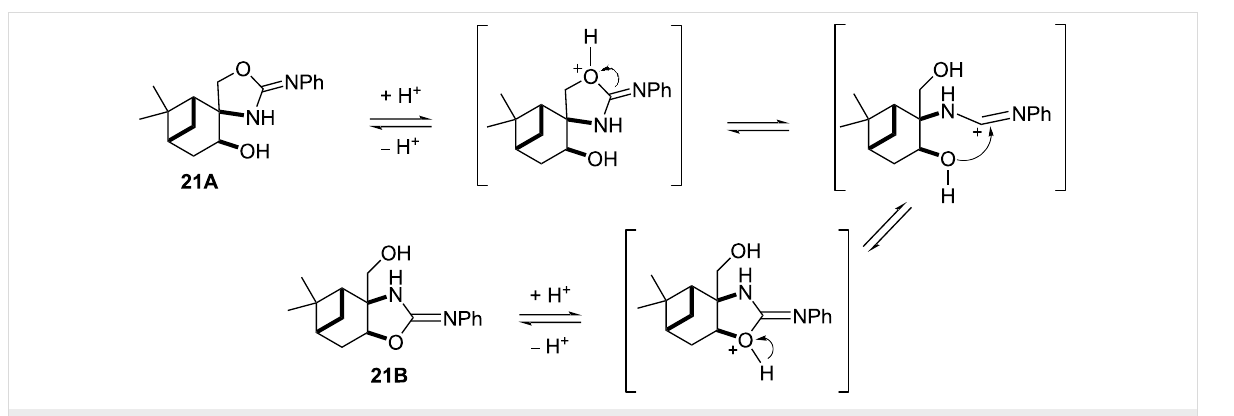
Figure 4: Proposed pathway for the ring–ring